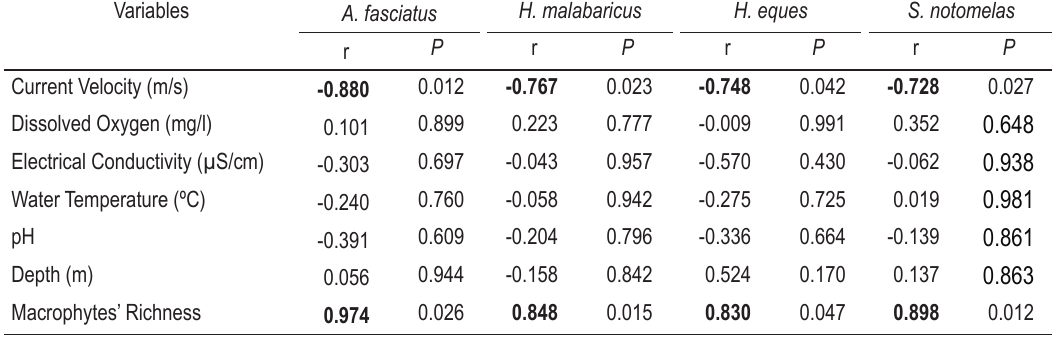
Table 3. Pearson’s Correlation between the relative condition factor of juveniles and some characteristics of the studied sites (Figure 1). The statistically significant values are presented in bold.